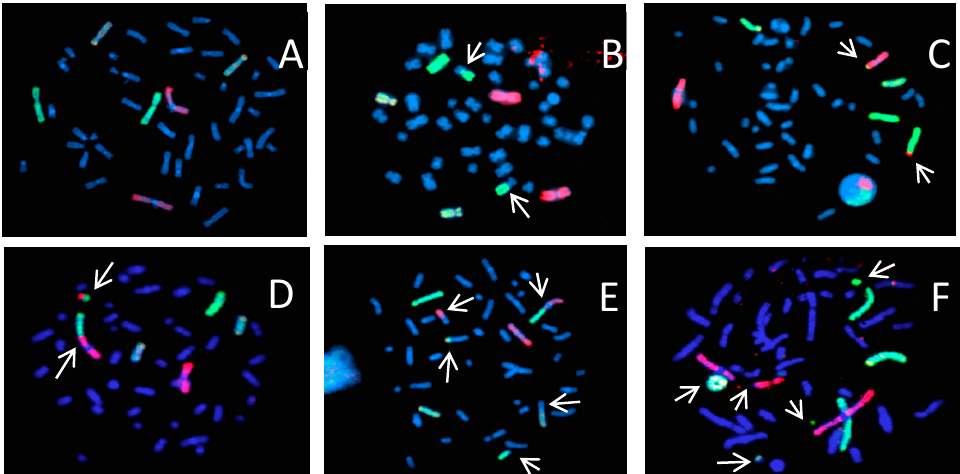
Figure 1. Examples of chromosome painting in human fibroblasts (82-6hTERT) with a 3 color whole chromosome FISH: Chromosome 1 (red), chromosome 2 (green), and chromosome 4 (yellow).